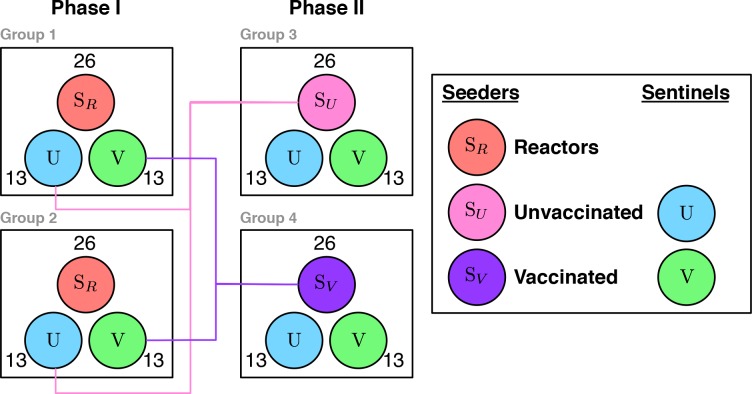
Experimental transmission study to demonstrate vaccine efficacy Both phases consist of two experimental groups with 52(4N) co-housed animals.Within each experimental group there is a balanced number of seeder (26,2N) and sentinel animals (26,2N). 50% of the sentinel animals are vaccinated (N=13) and 50% unvaccinated controls (N=13). For Phase I the seeders (SR) are recruited from the field. At the end of Phase I, the exposed control animals and vaccinated animals are group together and used as the seeder animals (SU and SV respectively) and set in contact with a fresh set of (uninfected) sentinels.